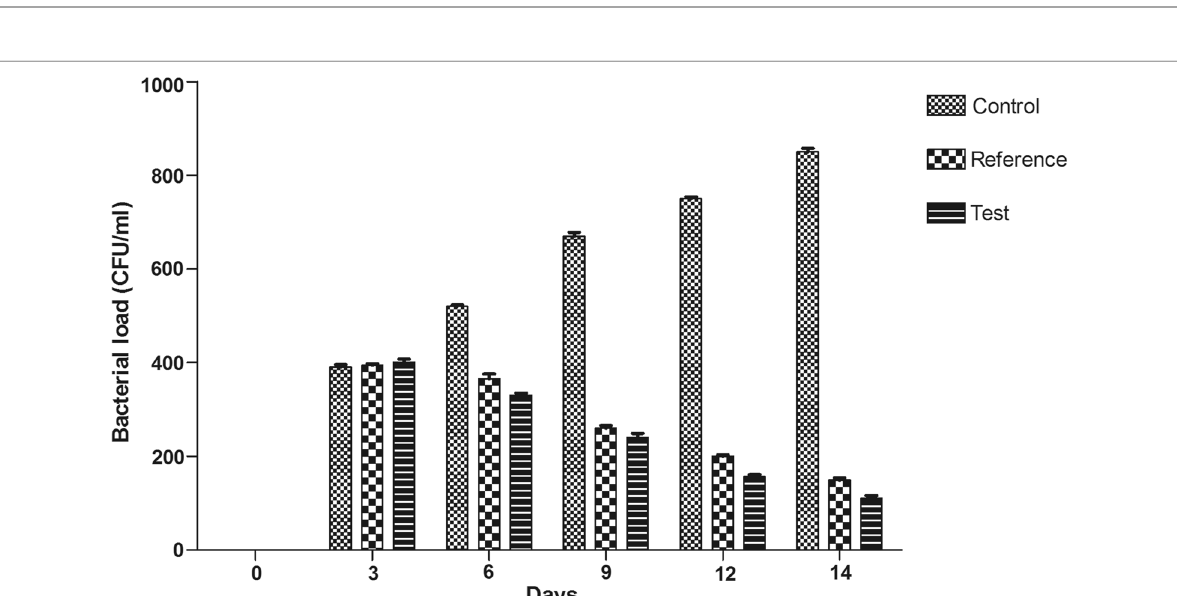
Fig. 9 Effect of OVMS on bacterial load in synovial